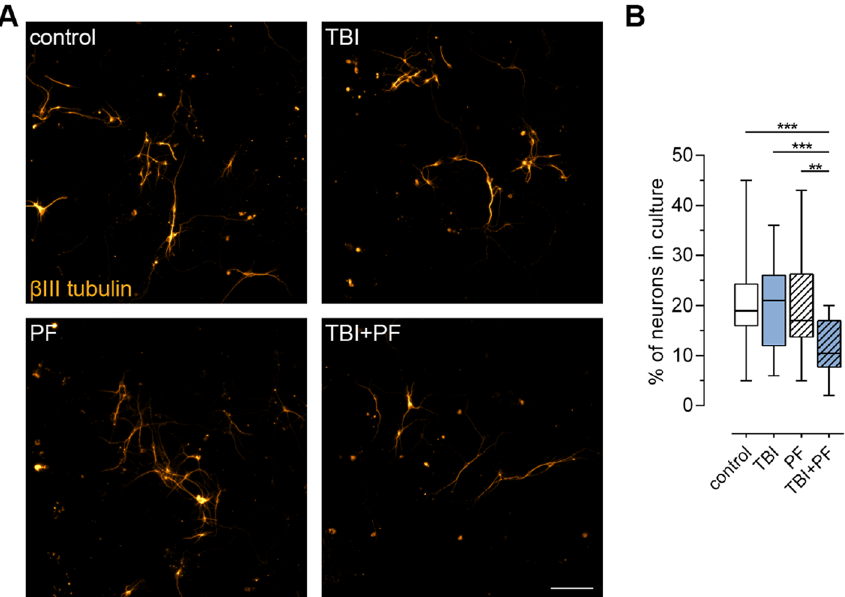
Figure 2. The number of neurons in culture declined following the combined exposure to Aβ 42 protofibrils and TBI. ( A ) Representative fluorescence microscopy images of neurons (βIII tubulin) and ( B ) the percentage of neurons in culture (calculated by reference to the total number of viable cells). The percentage of neurons in cultures exposed to Aβ 42 protofibrils and TBI alone did not differ from control cultures, while the combination (TBI + PF) resulted in a lower percentage of neurons. Ten images per independent cell culture (n = 3) and experimental group were analyzed and reported. Statistical analysis was performed using the Kruskal–Wallis test followed by Dunn’s multiple comparisons test, *p ≤ 0.05 **p ≤ 0.01 ***p ≤ 0.001. Scale bar 100